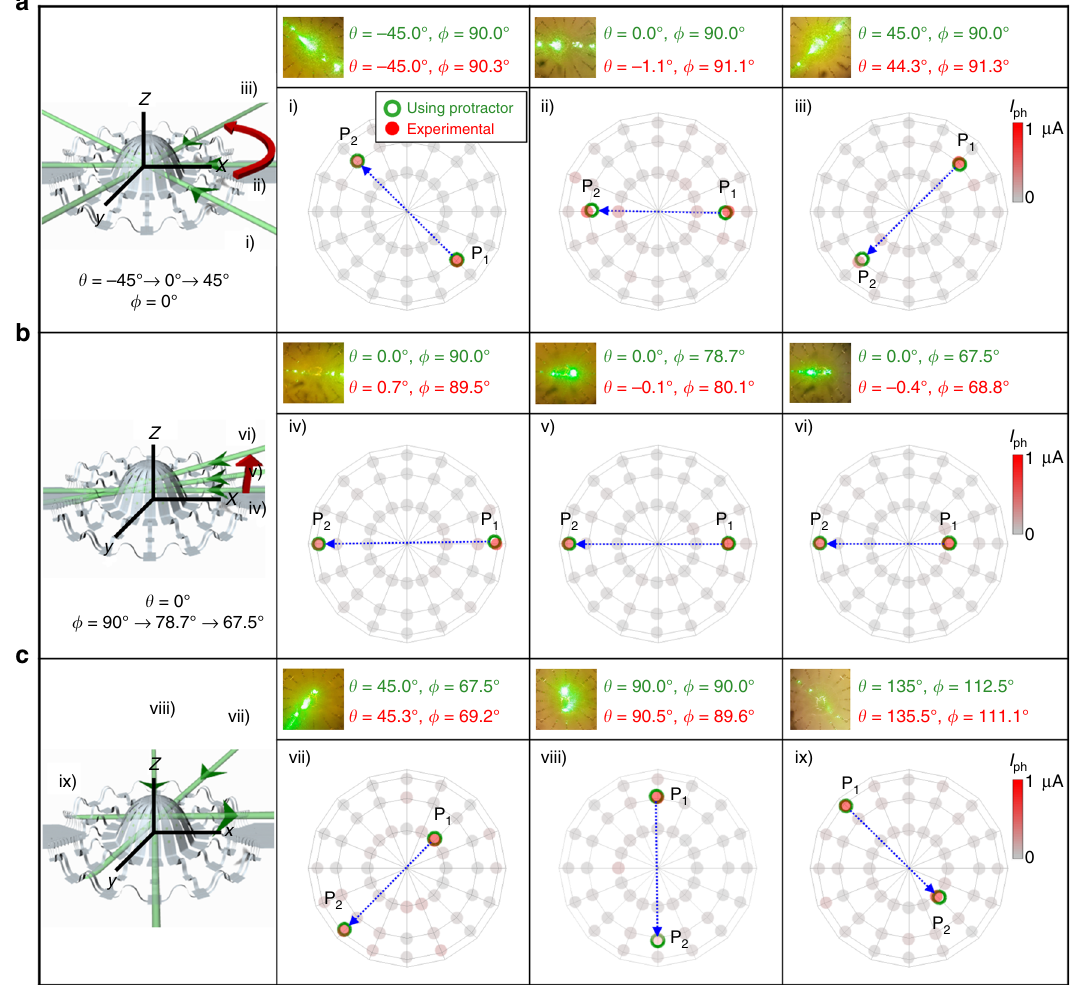
Fig. 4 Sensing characteristics of a 3D photodetection and imaging system. a Maps of photocurrent measured across the 3D surfaces. The incident angle θ ranges from − 45° to 45° with φ fi xed at 90°. The measured θ and φ from the device arrays are shown for comparison. b Similar results with φ ranging from 90° to 67.5° and θ = 0°. c Photocurrent maps of the photodetector array on the 3D surfaces randomly penetrated at two points by the incident laser. The incident angles are (from left to right) θ = 45°, φ = 67.5°, θ = 90°, φ = 90°, and θ = 135°, φ = Fig. 17), as summarized in panels (a) – (c) of Fig. 4 along with the spatial mapping of the photoresponse. Corresponding bar graphs are in Supplementary Fig. 18. Note that although the system can map 360° rotations of θ in the x − y plane, the φ movement is limited by the array geometry, which imposes lower and upper circumferences on the hemispherical surface; see Supplementary Fig. 19. Simple modi fi cations allow up to 45° movement of φ (Supplementary Fig. 20). All measurements and analysis can be performed in real time, as shown in the video clip of the sup- porting materials (Supplementary Movie 3). Further, the degree of accuracy in determining the position and direction improves with decreases in the distances between photoresistors and in the laser spot sizes (Supplementary Figs. 21 and 22). Moreover, the representative 3D photodetector showed good imaging capability in kHz range (Supplementary Fig. 23).